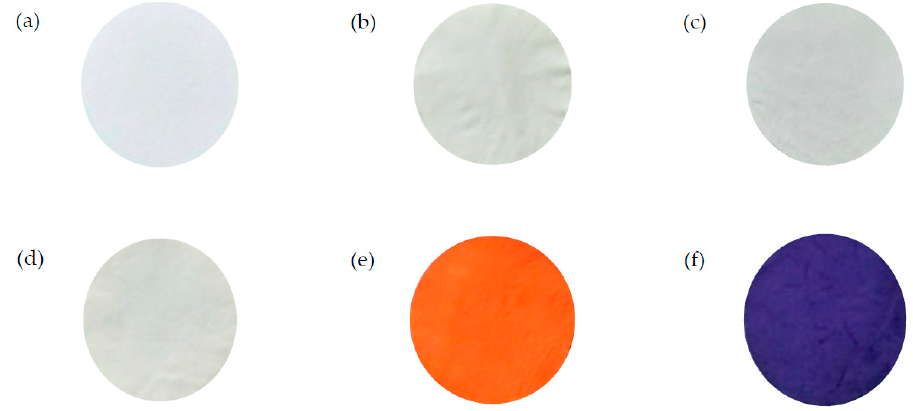
Figure 7. Photos of nanofiber membranes: ( a ) PAN, ( b ) P-COOH, ( c ) P-COOH-CS, ( d ) P-COOH-CS- CEW, ( e ) P-COOH-CS-CEW treated with AO7, and ( f ) P-COOH-CS-CEW treated with